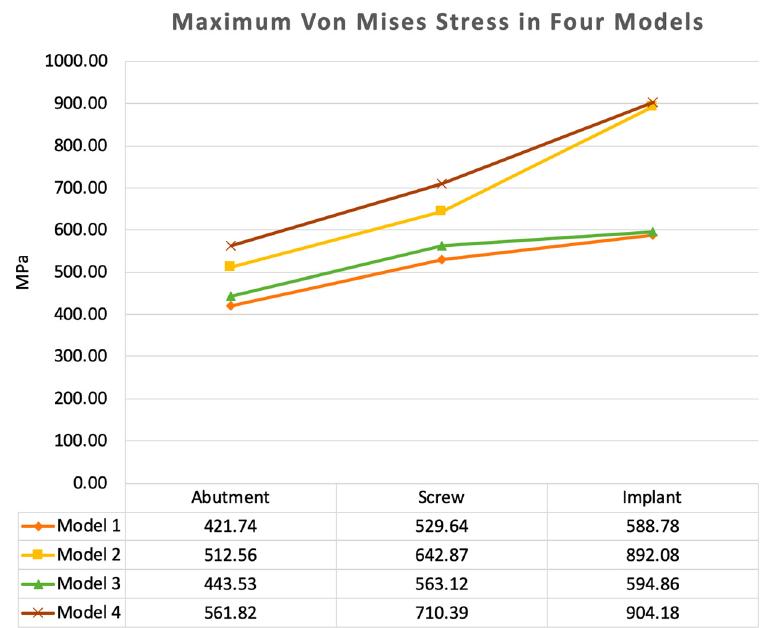
Figure 5. Maximum von Mises stress values for all the components of the models. Marginal bone loss and aftermarket screws were both were associated with an increase in the stress in the implants and prosthetic components.